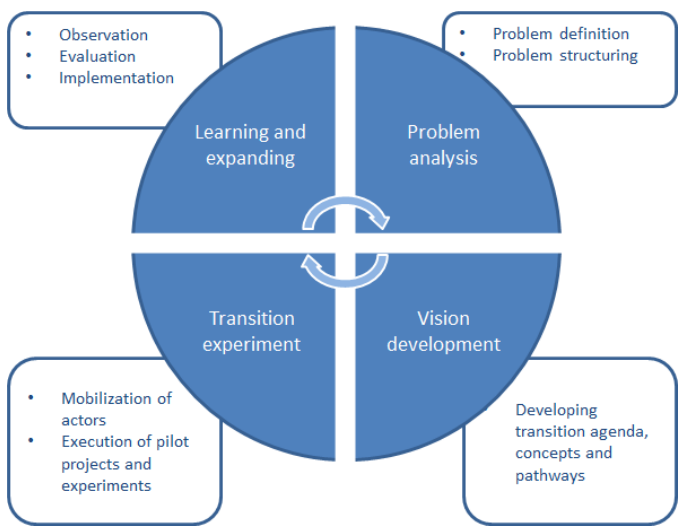
Figure 1: The Transition-Cycle